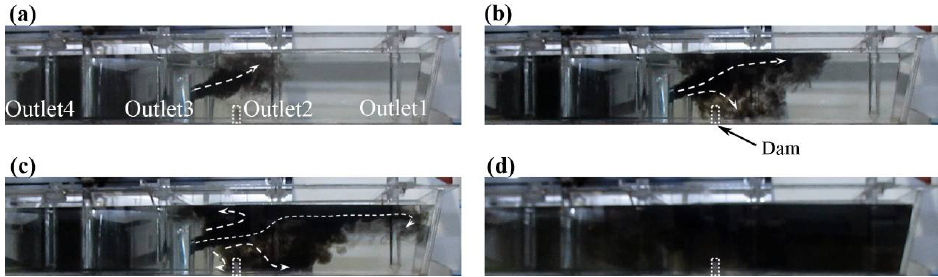
Figure 10. Ink dispersion behavior in case B8: ( a ) 30 s, ( b ) 68 s, ( c ) 95 s, ( d ) 309 s. Table 10. Flow characteristic parameters of tundish in isothermal experiment Part C.